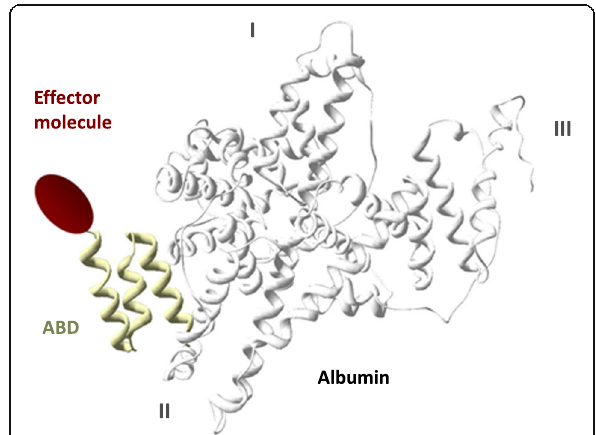
Fig. 1 The Albumod technology (schematic model). The Affibody albumin-binding domain (ABD) protein (yellow) binds to albumin (gray/white, crystal structure, PDB no: 1TF0) via a regioselective, tight interaction with domain II as earlier demonstrated by Johansson [20] and based on crystal structure by Lejon [21]. Effector molecules (red) are site-specifically attached to ABD in a position remote from the albumin binding surface. The effector molecule is thus held in circulation with a biological half-life similar to that of albumin, thereby increasing the probability that the administered effector molecule will reach (and interact) with its target. For radiodiagnostics, the effector is a radionuclide. For therapeutics, the effector may be a therapeutic radionuclide, targeting drugs, particles, or fusion